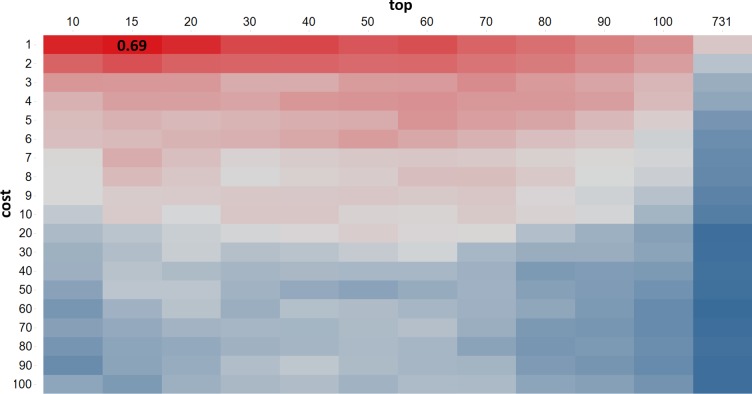
Heatmap of AUC under different cost and top settings.Each row is individual cost values while each column represents individual top values, and each cell is the averaged AUC over 500 training sets. The best averaged AUC is 0.69, when cost = 1, top = 15.